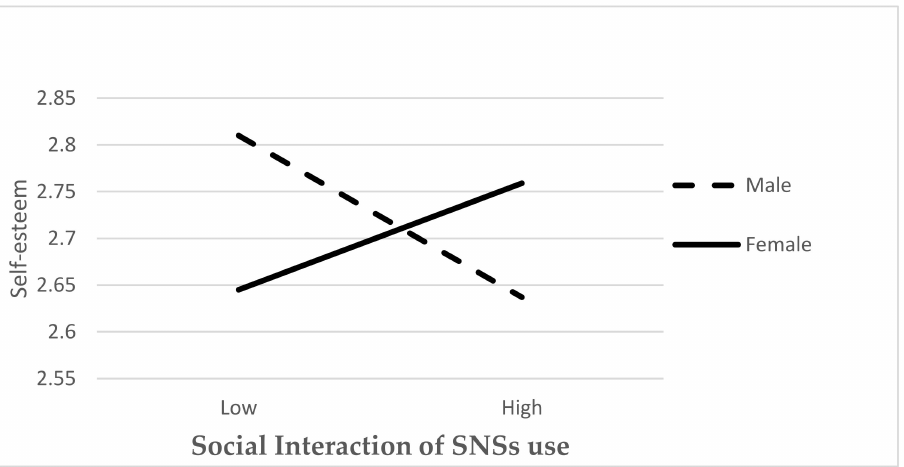
Figure 2. The moderating effect of gender on the relationship between social interaction of SNS use and